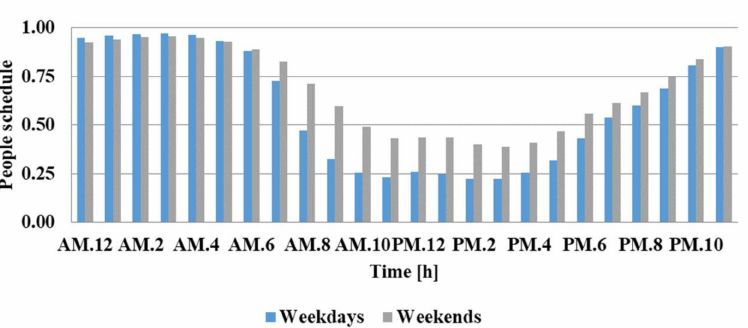
Figure 14. People schedule from Statistics Korea’s survey.